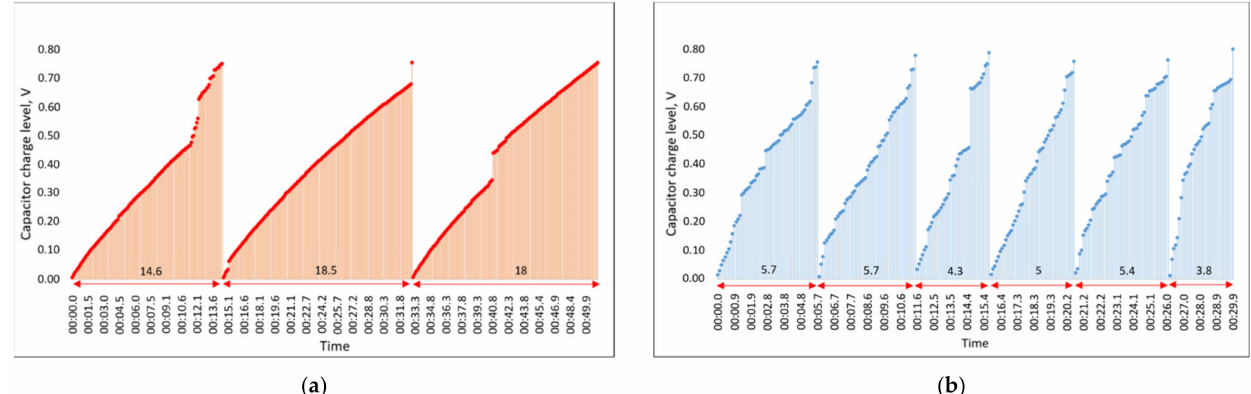
Figure 16. Experimental results of the capacitor C4 charging times when the tool holder without ( a ) and with ( b ) helical slots is used during milling operation, with the depth of cutting increased from 1 mm to 1.5